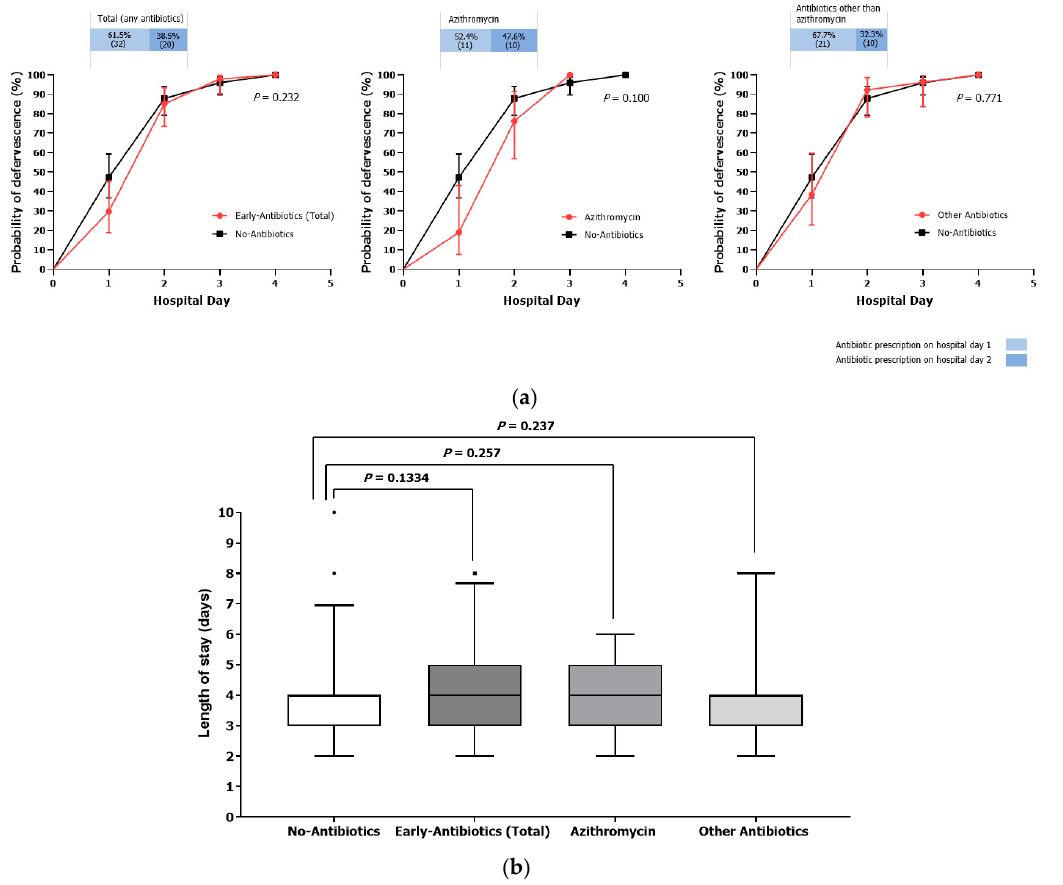
Figure 3. Comparison of fever defervescence curves ( a ) and length of stay ( b ) between the early and no antibiotic groups. The error bar in Figure 3a indicates 95% confidence intervals. The box plot in Figure 3b shows median and interquartile range. The error bar in Figure 3b indicates 2.5–97.5 percentile.